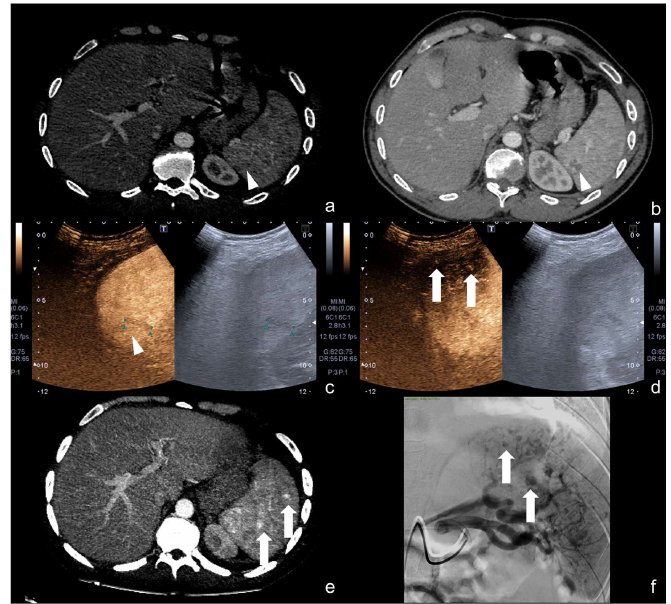
Figure 25. Splenic trauma in car accident with small splenic laceration visible on contrast-enhanced CT scan performed at emergency department ( a , b , white arrowhead). CEUS examination performed 4 days after trauma confirmed the splenic laceration ( c , white arrowhead); subsequent Flash mode CEUS ( d ) revealed multiple, small and diffuse intra-splenic PSAs (white arrows) not shown at admission arterial phase CT exam ( a ); these findings were confirmed at contrast enhanced CT scan ( e , arrows) and angiography ( f , arrows).